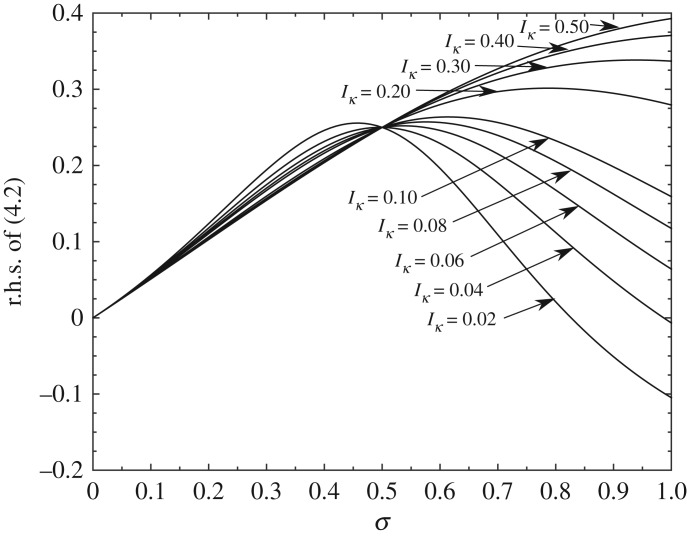
The right-hand side of (4.2) versus the original contact location σ for varying I^κ (shown as Iκ) ranging from 0.02 to 0.5. Body has a parabolic shape.